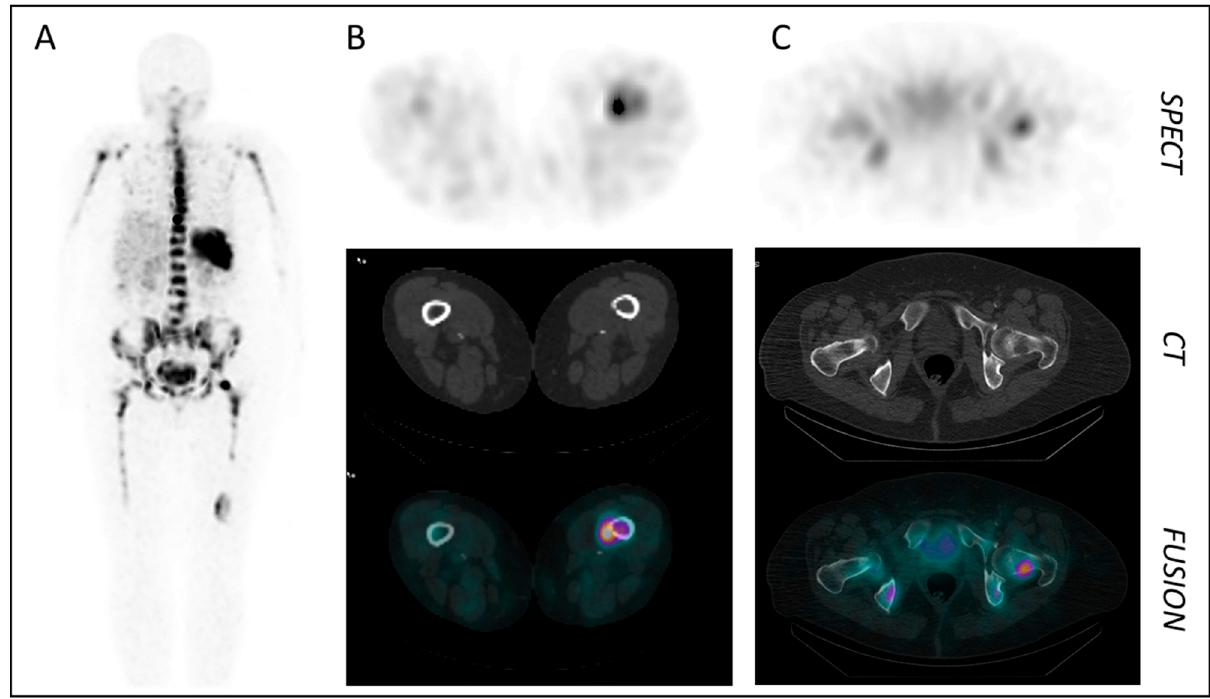
Figure 4. CXCR4-targeted SPECT/CT imaging in a patient with multiple myeloma (MM) using [ 99m Tc]PentixaSPECT. ( A ) MIP at 3 h p.i. ( B , C ) Axial SPECT, CT and fusion images of intramedullary MM lesions in the femur ( B ) and the femoral head ( C ) (3 h p.i.) [78].